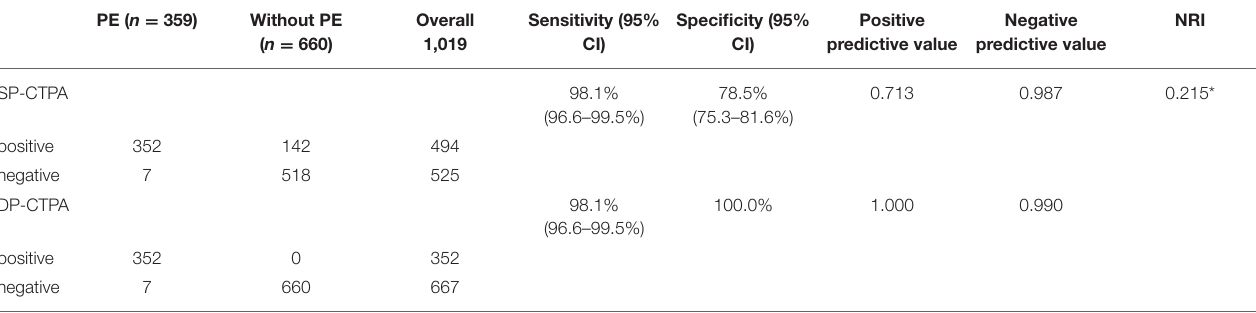
TABLE 2 | Coincidence between single phase-computed tomography pulmonary angiography (SP-CTPA) and dual phase-computed tomography pulmonary angiography (DP-CTPA) in the diagnosis of PE and the FCD.